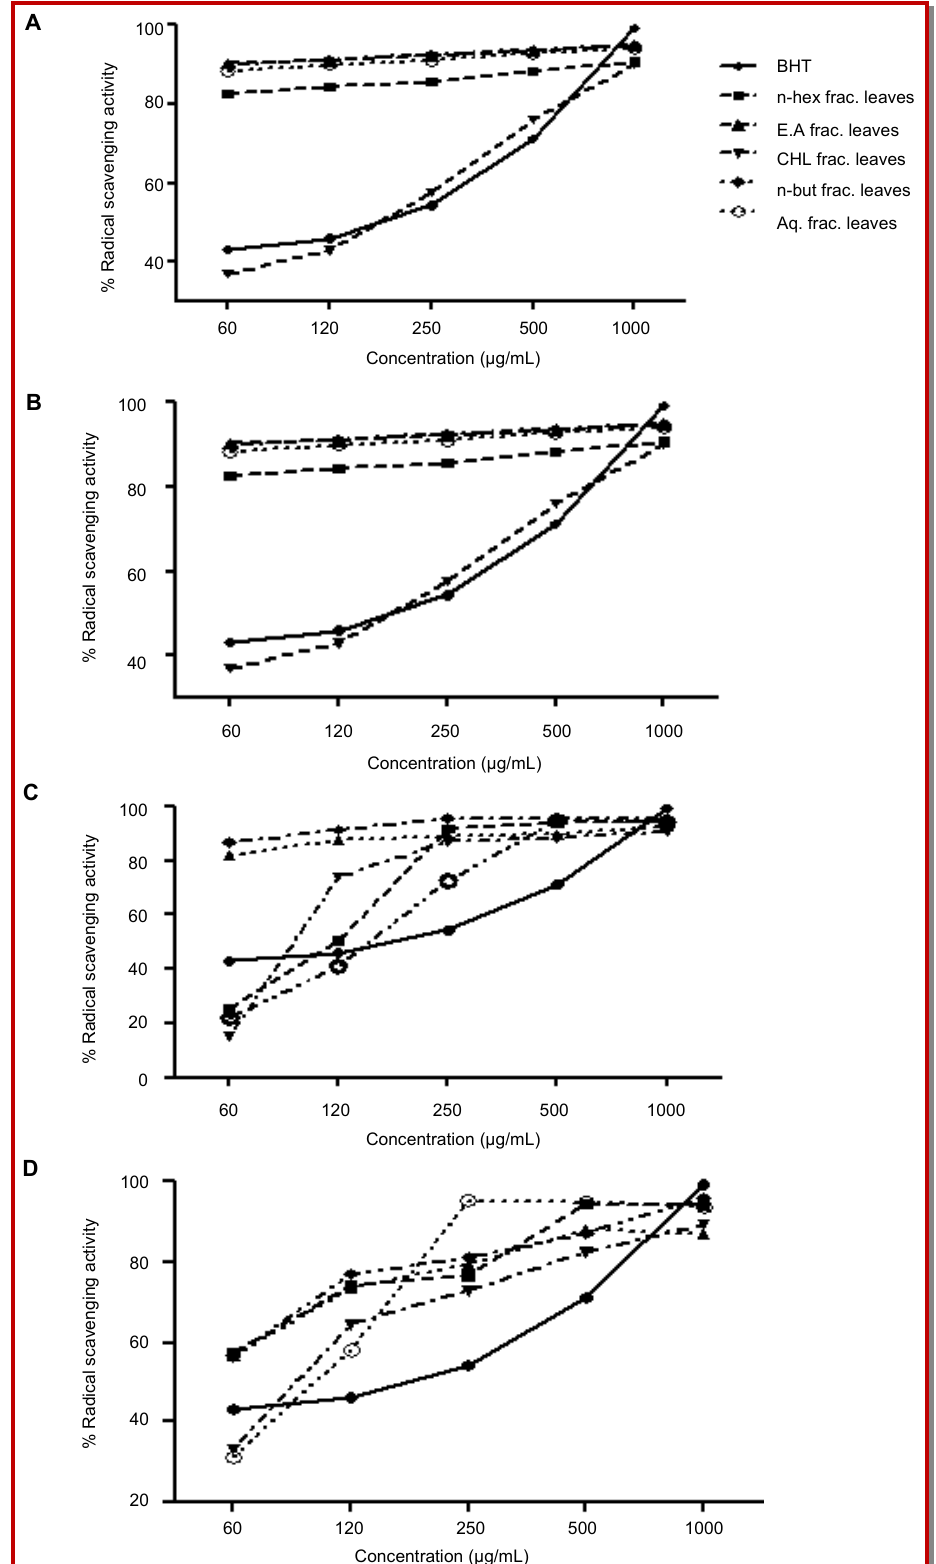
Figure 1: Comparison of DPPH radical scavenging activity. A & B Comparison of percentage radical scavenging activity of various fractions of L. pulverulentus ( D. sissoo ) leaves and stems. C & D Comparison DPPH radical scavenging action of several fractions of L. pulverulentus ( P. nigra